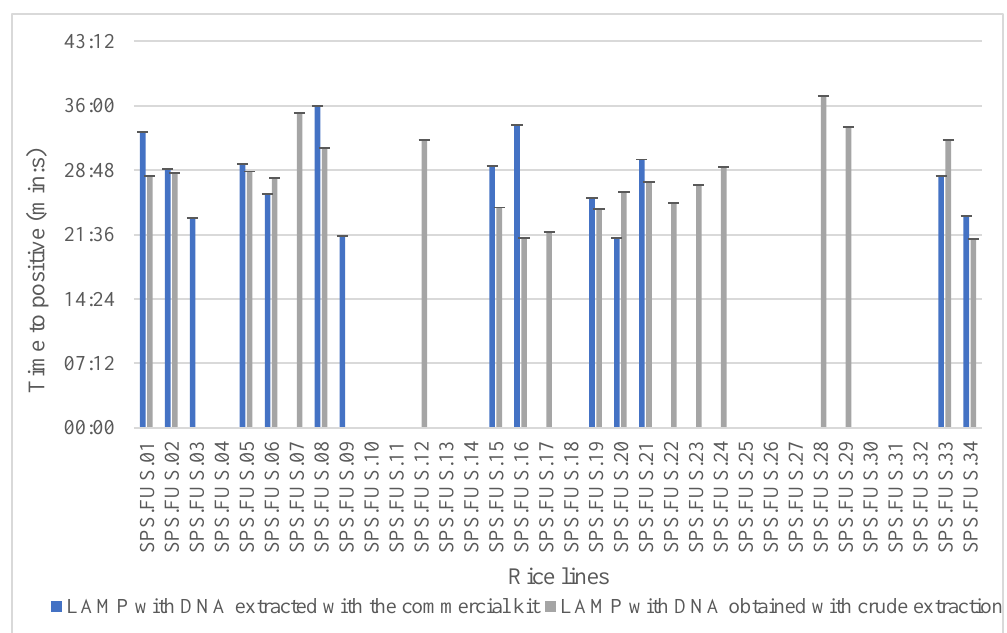
Figure 6. Results obtained with LAMP in which 34 rice lines were used and the DNA was extracted using a kit extraction method and a crude extraction method in triplicate. The graph shows the time to positive (Tp) obtained using both types of DNA extraction method among the different rice lines. The values are the means ± standard deviations (ANOVA, Tukey test, p ≤ 0.05).